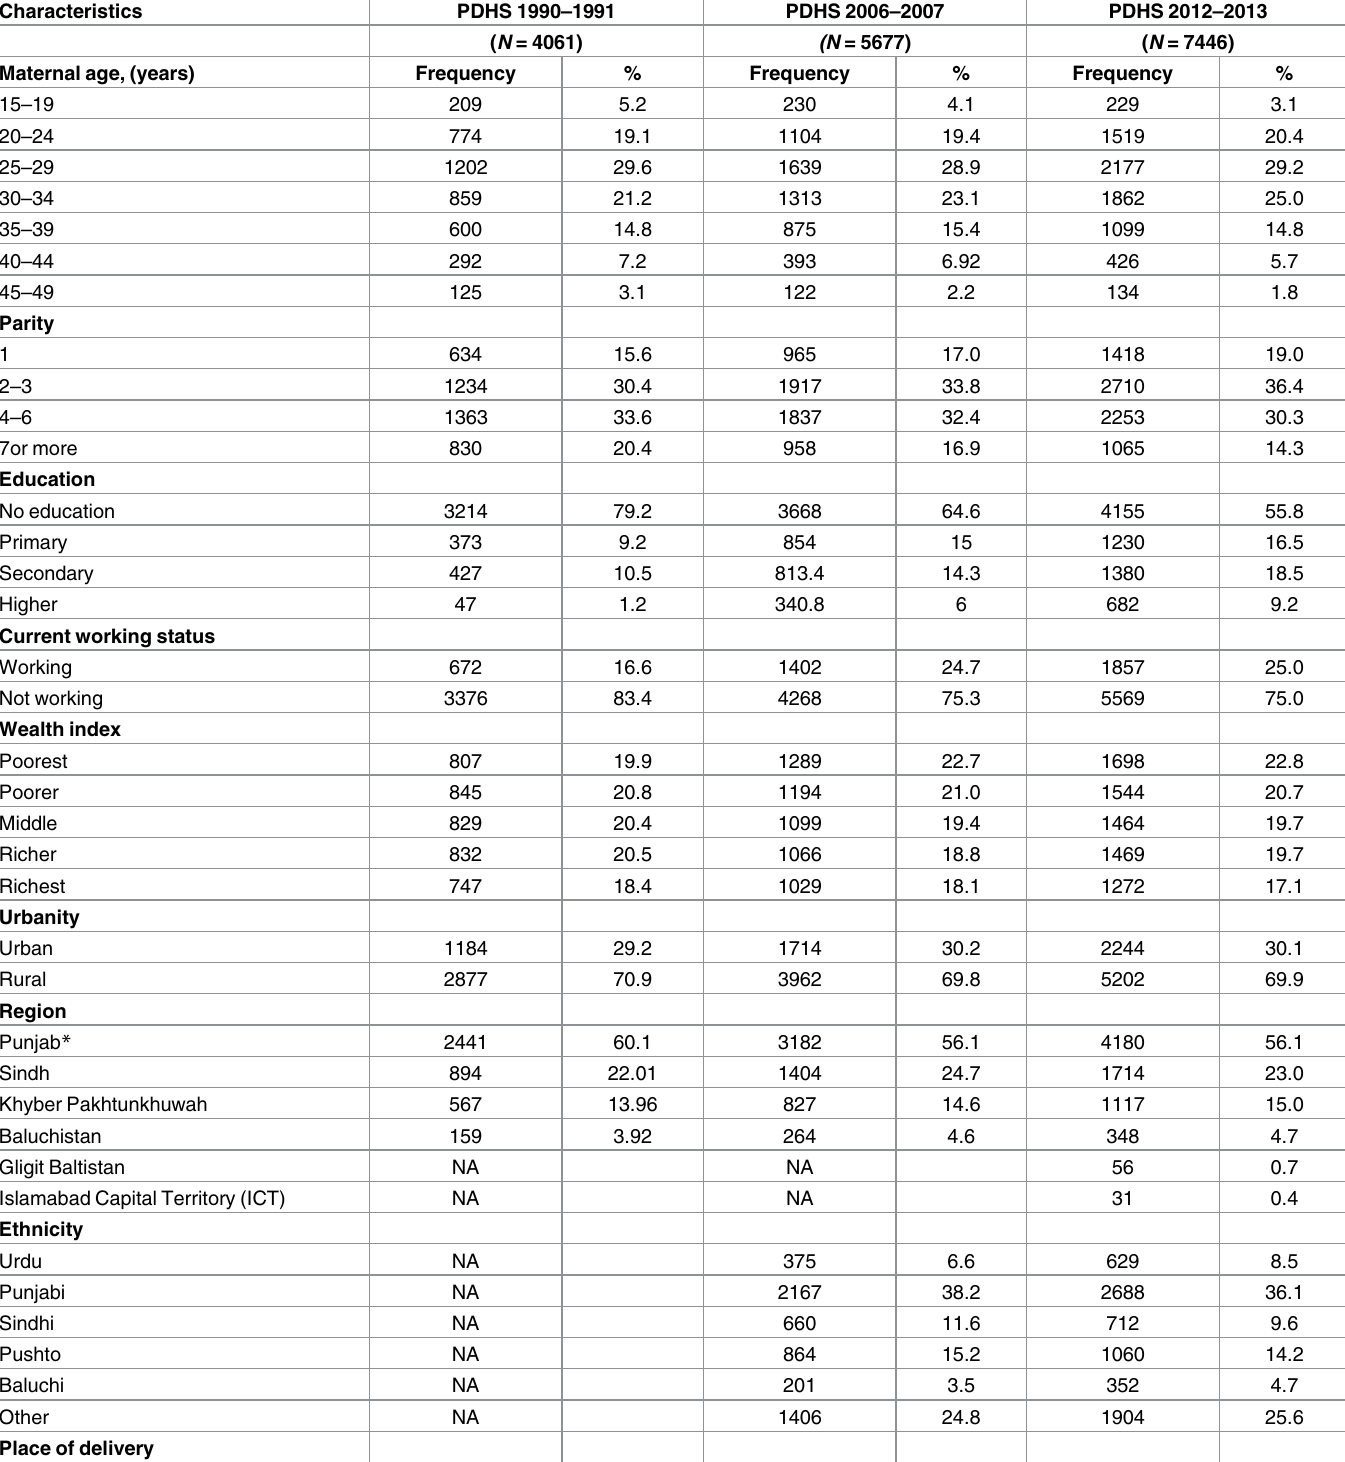
Table 1. Socio-demographic characteristics and the use of cesareansection from the Pakistan Demographic and Health Surveys(PDHS) in 1990– 1991, 2006–2007, and 2012–2013.